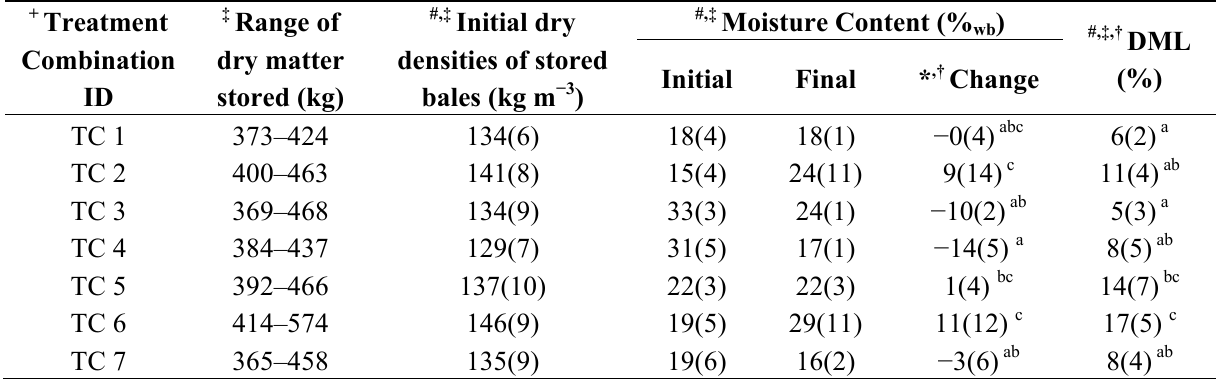
Table 2. Summary of physical properties of bales stored under different treatment